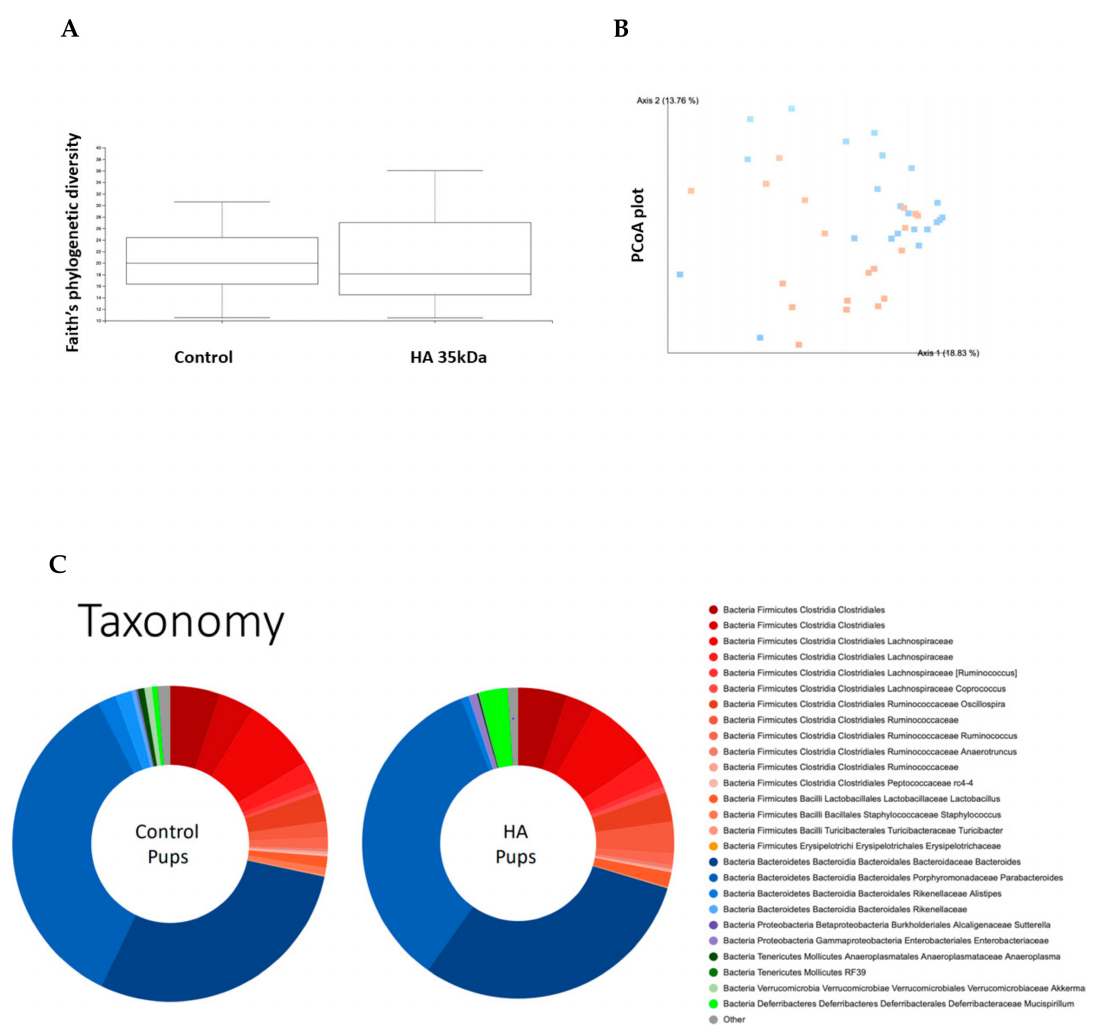
Figure 4. Analysis of cecal microbiota composition between groups. ( A ) Faith’s phylogenetic diversity metric displaying species richness of mouse pups differentiated by treatment ( n = 41; Kruskal–Wallis p = 0.69). ( B ) PCoA plot displaying Bray Curtis beta diversity matrix (Control = orange; HA 35 KDa = blue). Percent confidence values for each distance matrix are displayed on the axes in two dimensions. PERMANOVA results: F = 3.10; p = 0.002. ( C ) Taxonomy plots generated using a Naïve–Bayes classifier trained on the most recent Greengenes 16S rRNA database. Amplicon sequence variance (ASV) reads were taxonomically classified and filtered for genera >0.5% of total microbiome composition for any one sample. Genera falling below the 0.5% mark were placed in “other” (shown in grey). HA: hyaluronic acid; PCoA: principal components